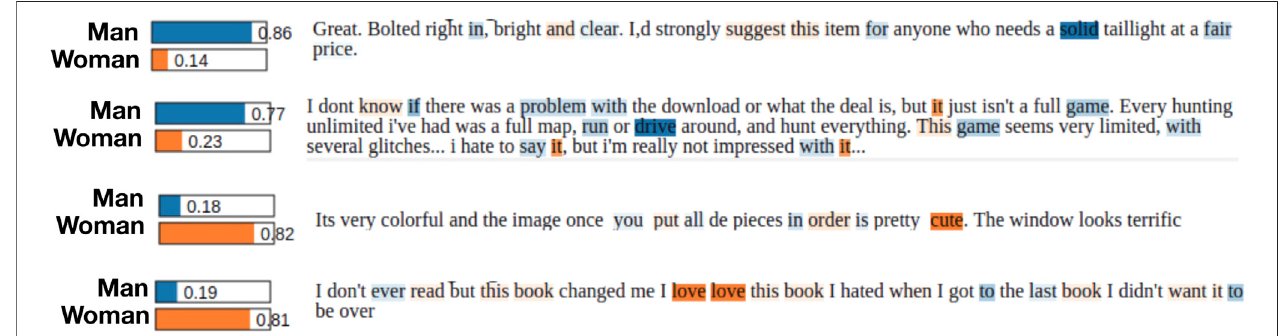
FIGURE2| Distinctivewritingpatternsofinferredmenandwomen.The fi rsttwoexamplesarecaseswheretheLogRegmodelpredictsthattheauthorisasignaling man with high probabilities (0.86 and 0.77 respectively) while the classi fi er predicts that the second pair of texts were very likely written by signaling women. Noticeably, themodelgivesmoreweighttowordssuchas “ solid, ”“ drive ” etc.forthe fi rsttwocaseswherethemodelpredictsthegender.Forthenexttwoexamplesthemodelgives more weight to words such as “ love, ” “ cute ” etc. These exploratory results suggest that there exist differences in writing styles between gender signaling men and women while reviewing a product on